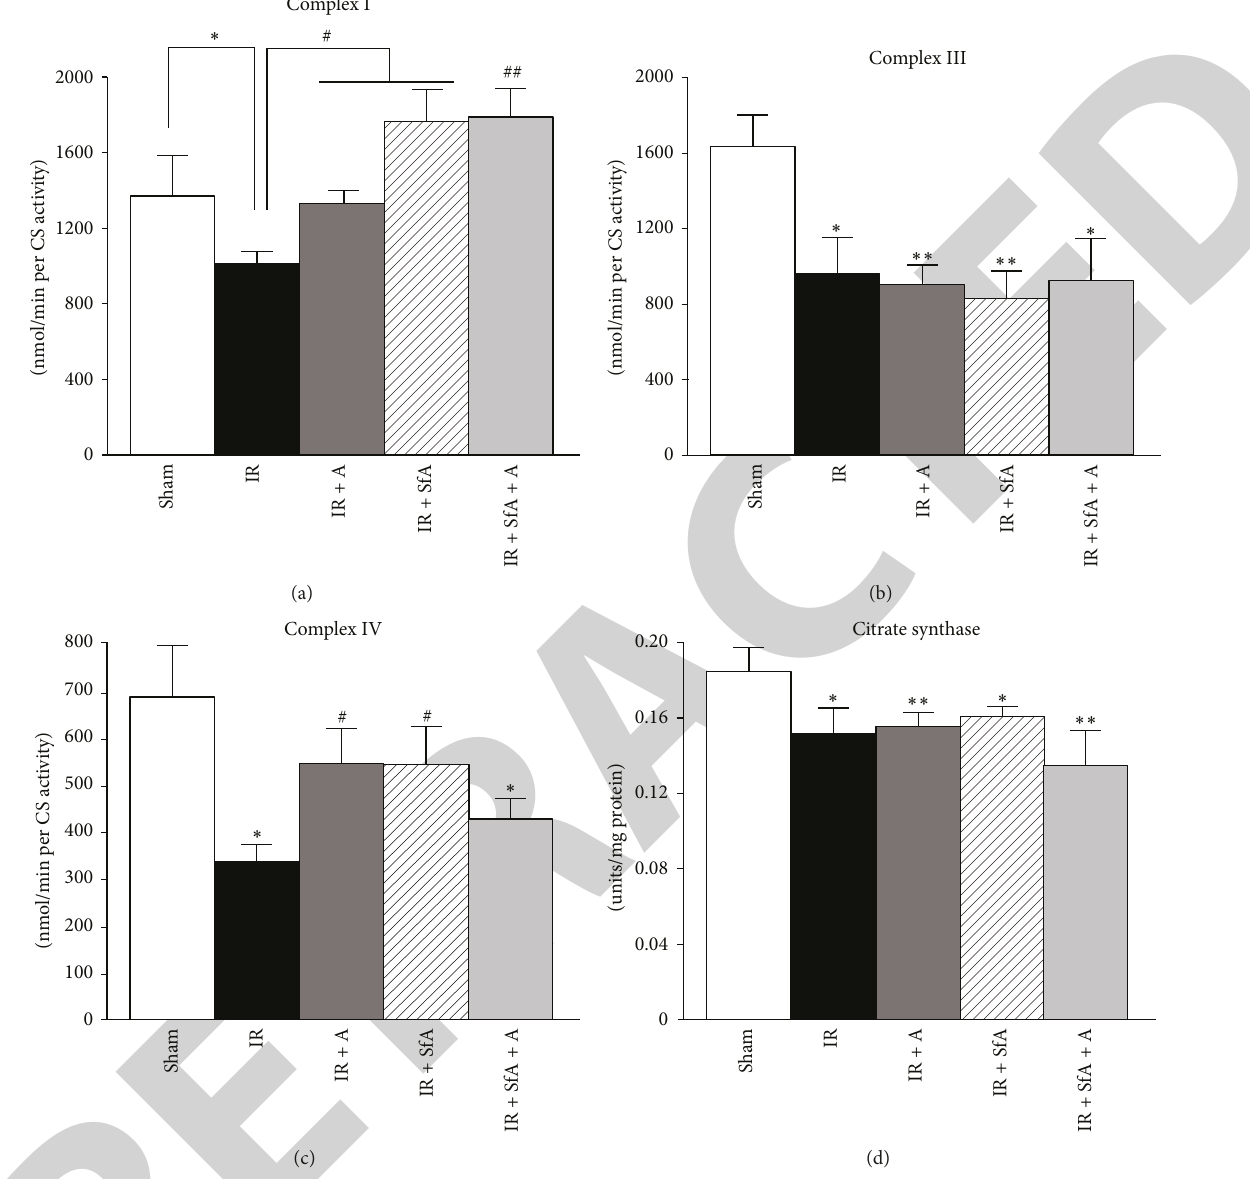
Figure 5: Effects of SfA, A-769662 or their combination (A) on the activity of the ETC complexes I (a), III (b), and IV (c), and citrate synthase (d) in cardiac mitochondria. Activities of ETC complexes and citrate synthase (CS) were normalized to citrate synthase or mg mitochondrial protein, respectively. # 𝑃 < 0.05 , ## 𝑃 < 0.01 versus IR, ∗ 𝑃 < 0.05 , ∗∗ 𝑃 < 0.01 versus